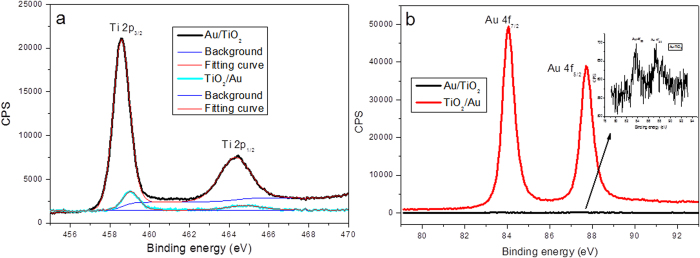
High resolution XPS spectra of (a) Ti and (b) Au for FTO/Au/TiO2 (black) and FTO/TiO2/Au (red) photoelectrodes. The inset in Fig. 2b is the enlarged XPS spectra of Au for FTO/Au/TiO2 photoelectrode.